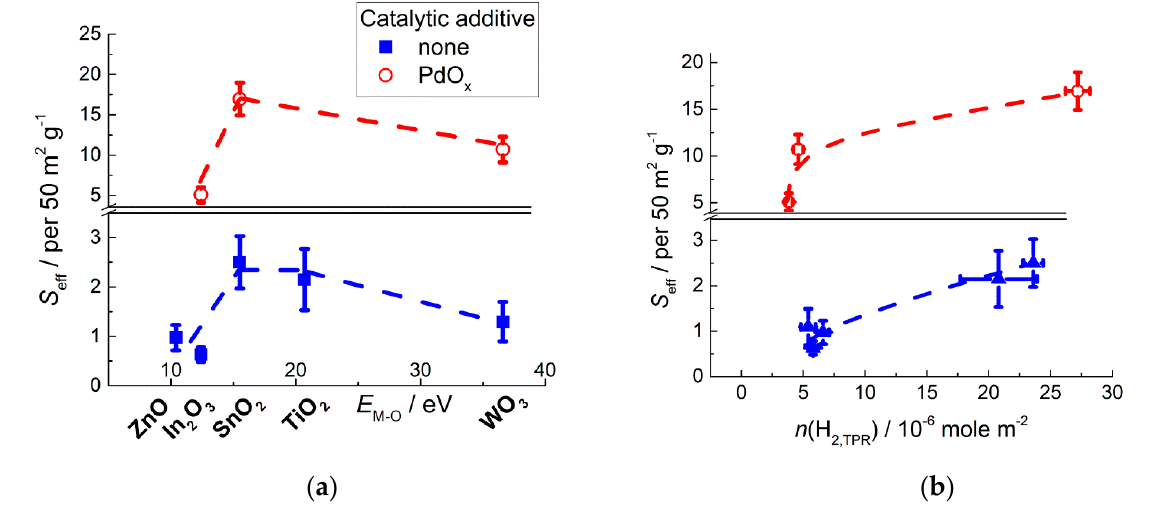
( a ) ( b ) Figure 18. Sensitivity of pristine and PdO x -functionalized nanocrystalline n -type MOS to 20 ppm CO at temperature 250–300 °C in relation to metal-oxygen bond energy in MOS ( a ) and acid sites concentration at the MOS surfaces ( b ). Adapted with permissions from ref. [75] copyright 2018 Elsevier; ref. [76] copyright 2019 by the authors (BB BY); ref. [87] copyright 2010 Elsevier; ref. [97] copyright 2018 by the authors (CC BY); ref. [120] copyright 2015 by the authors (CC BY).